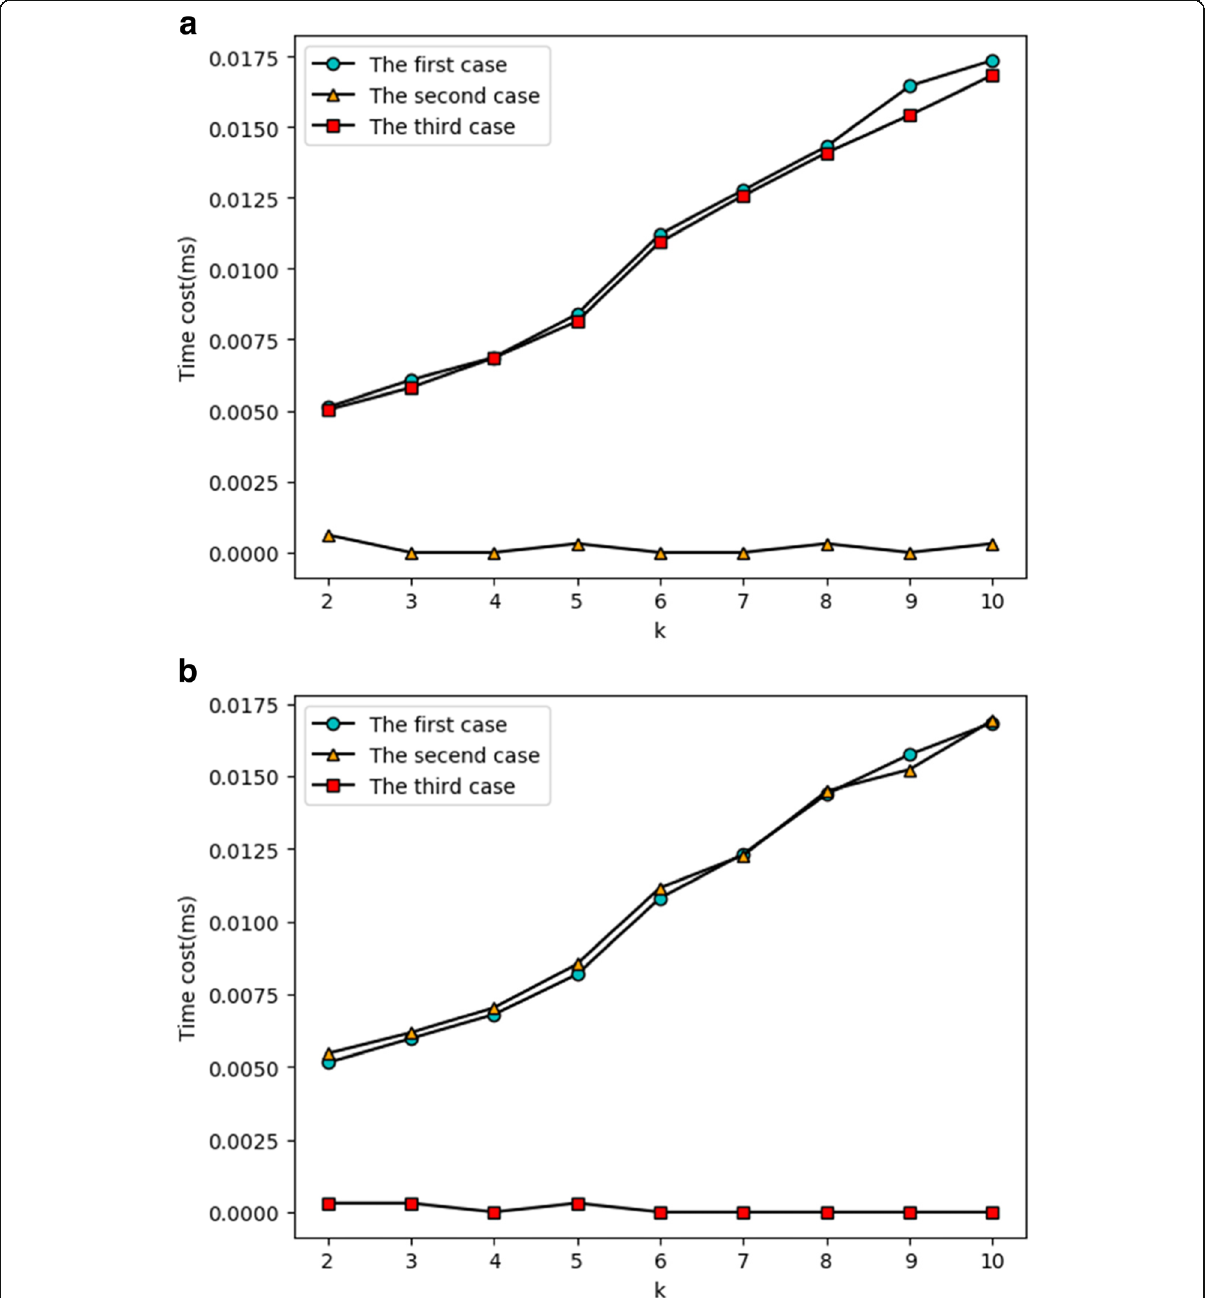
Fig 10 a The time spent on user ’ s location using the user ’ s location k -disturbance algorithm. As shown in a , line segments with blue solid circles, yellow triangle, and red square represent the time consumed of the first, second, and third query for different k -anonymous requirements, respectively. The first, second, and third cases correspond to the user location status when three kinds of users of the user's location k disturbance algorithm inquiry in chapter 4.2. b The time spent on user ’ s query target anonymity using the user ’ s query target k -disturbance algorithm. As shown in b , line segments with blue solid circles, yellow triangle, and red square represent the time consumed of the first, second, and third queries for different k -anonymous requirements, respectively. The first, second, and third cases correspond to the three cases of the user ’ s query target k -disturbance algorithm in chapter